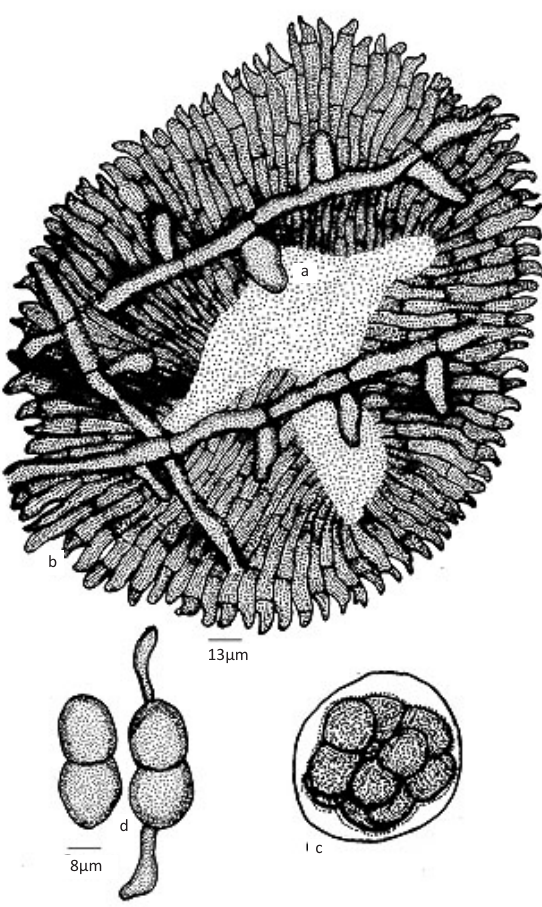
Figure 2. Asterina persigena sp. nov. a - Appressoriate mycelium; b - Thyriothecium; c -